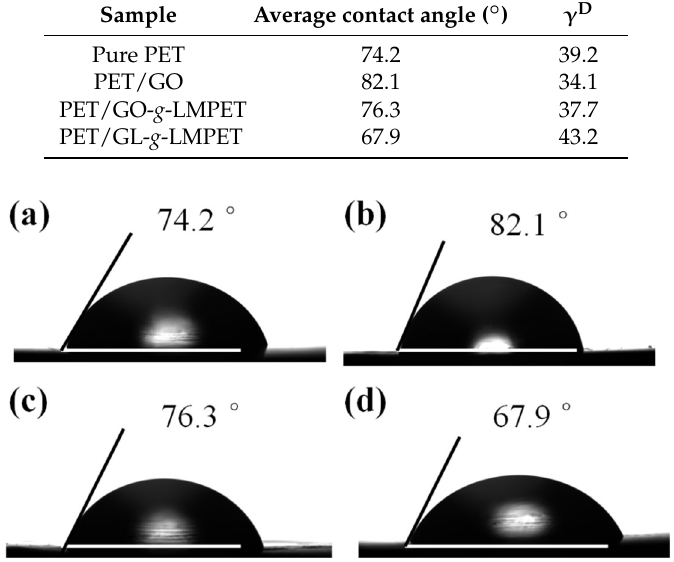
Figure 6. Pictures of water droplets on various nanocomposites: ( a ) pure PET; ( b ) PET/GO; ( c ) PET/GO- g -LMPET; and ( d ) PET/GL- g -LMPET.